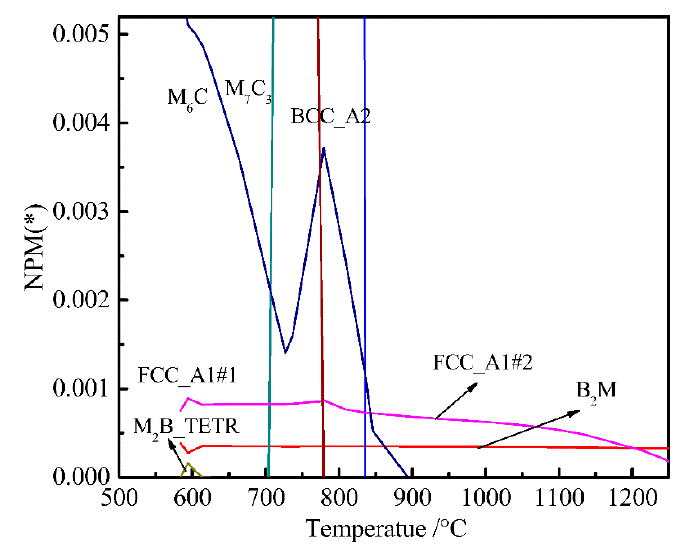
Figure 1. Temperature-chemical component equilibrium phase diagram of bainitic steel.